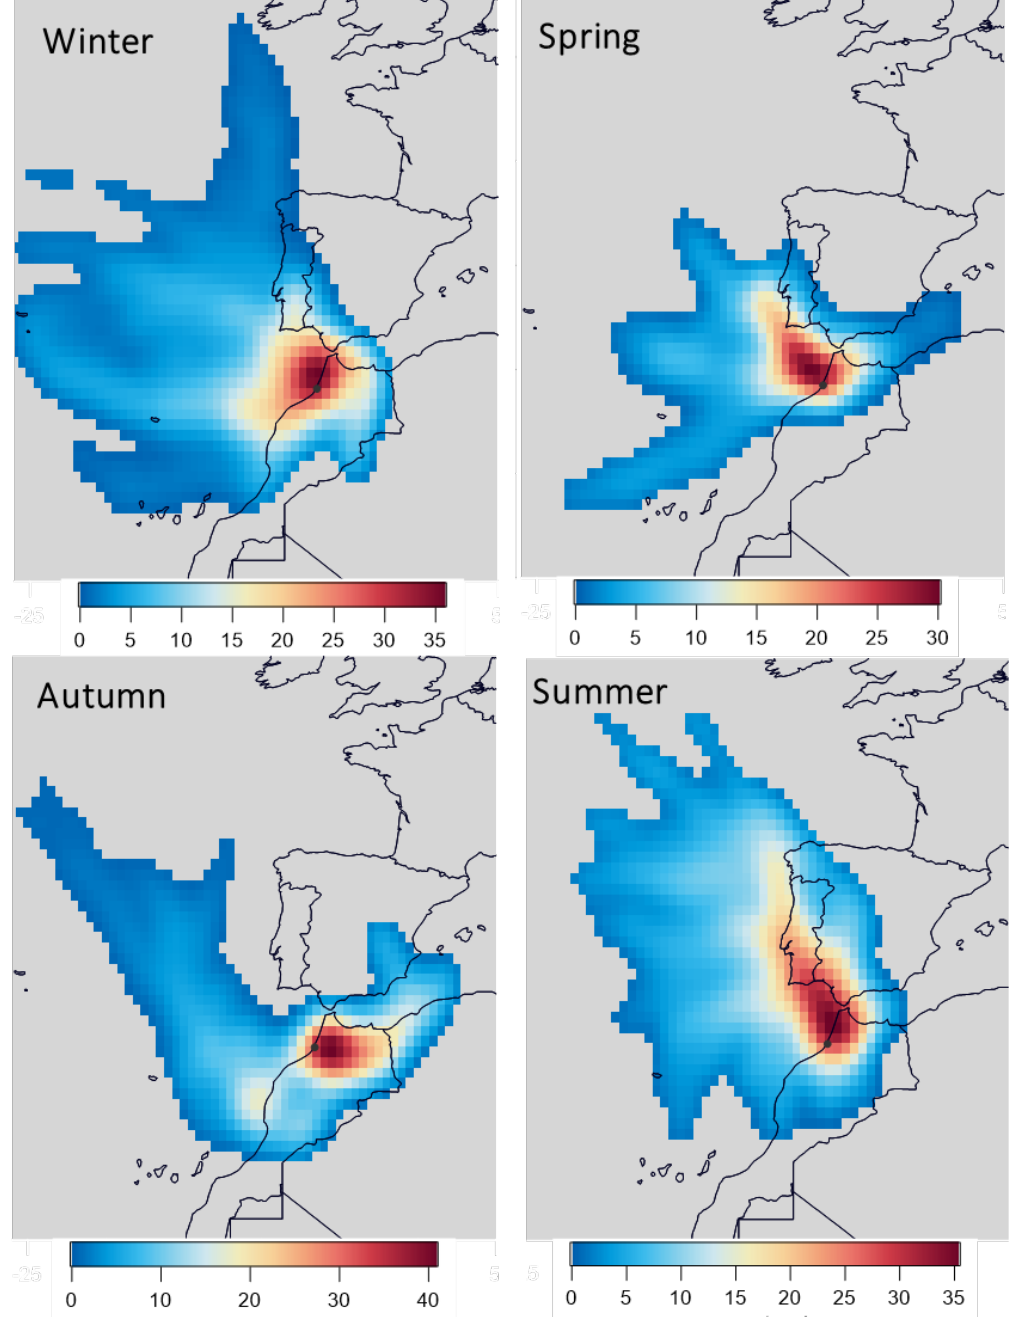
Figure 4. CWT maps for spring, summer, autumn, and winter in Kenitra. The red areas represent the main potential source-areas affecting PM 10 concentrations. Scales are in µg/m 3 .